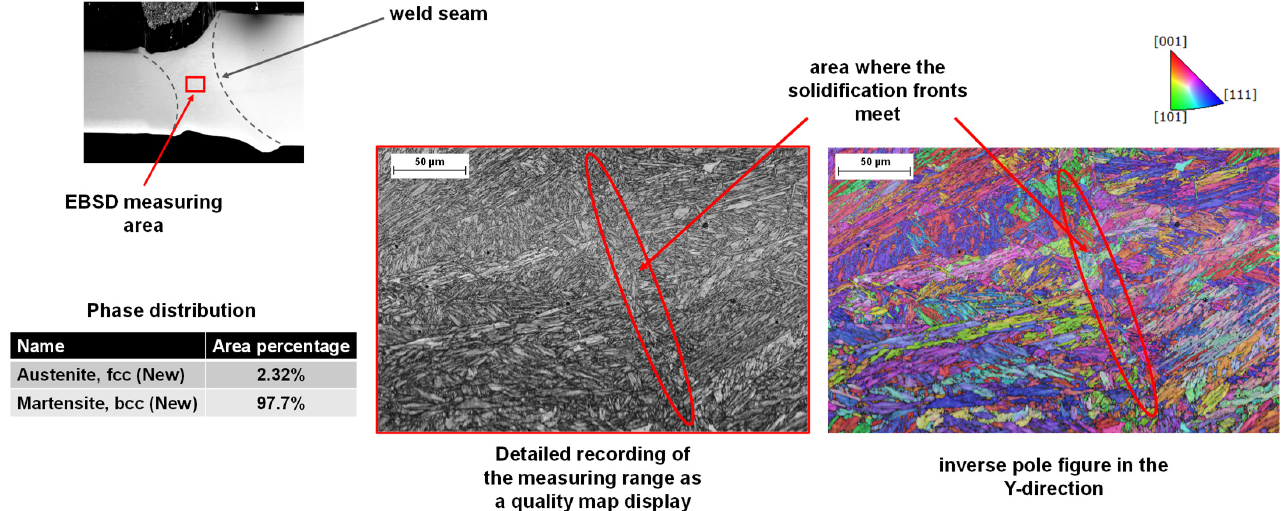
Figure 10. SEM image depicting the area for detailed EBSD-analysis of the microstructural evolution of tailored blanks welded wit ultrasonic soundwave superposition. Detailed EBSD-analysis obtained at a magnification of 400×. Grain orientations plotted parallel to the traverse direction.